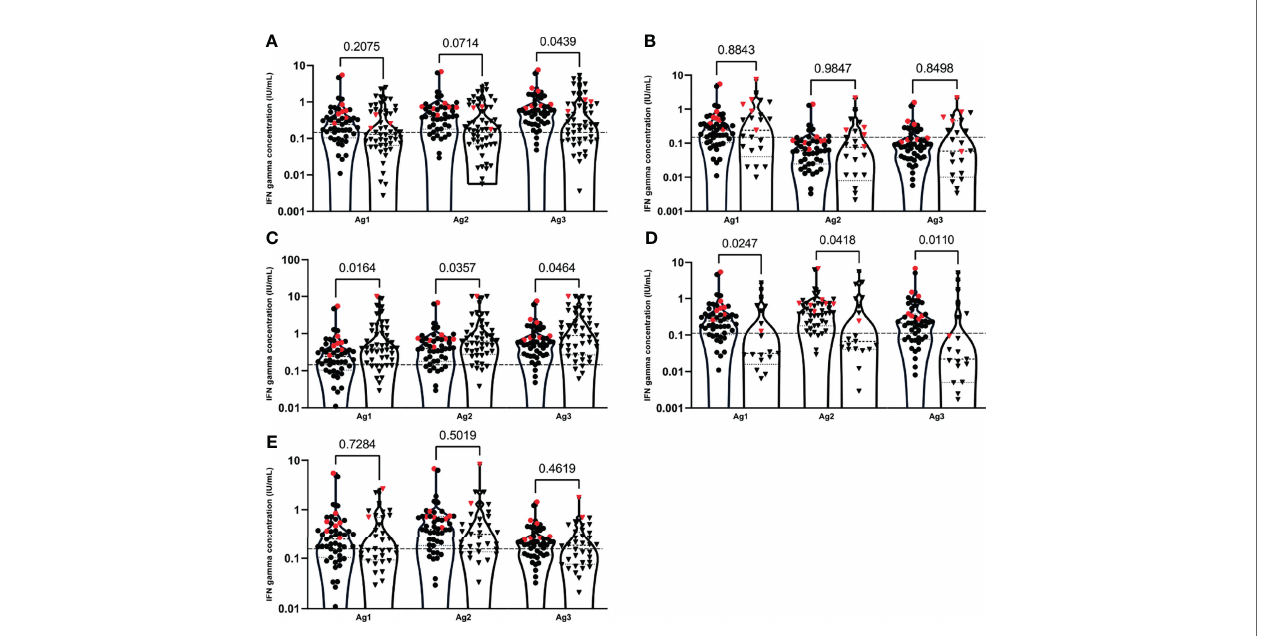
FIGURE 3 | IFN gamma concentrations after stimulation of T-cells with the different antigen pools (Ag1, Ag2 and Ag3) between the healthy control group ( ● ) and patient groups ( ▼ ): primary immune de fi ciency patient group (A) , PLWH (B) , neurology (C) rheumatology (D) and CKD (E) patient groups at T3. Patients with a documented Sars-CoV-2 infection are indicated with red symbols. Cellular responses were assessed by measuring interferon (IFN) gamma (IU/mL) by the QuantiFERON SARS-CoV-2 test on the Liaison XL analyser. Plots represent the median, 25th and 75th percentiles. Outliers were determined by 1.5 time IQR. Statistical signi fi cance was calculated by Mann-Whitney U test. Signi fi cance was de fi ned as a p-value < 0.05.